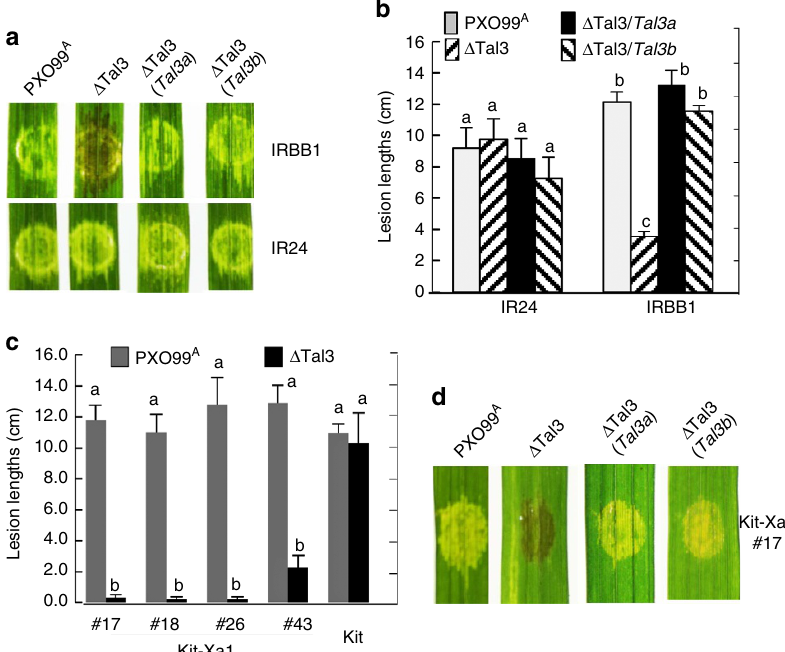
Figure 2 | iTALE genes Tal3a and Tal3b interfere with Xa1 resistance. ( a ) Disease reactions of IRBB1 and IR24. Strains are indicated above the leaves. Brown colouration indicates HR and clearing spots indicate disease reaction. ( b ) Lesion lengths in IR24 and IRBB1 caused by Xoo strains as measured at 12 days post inoculation (DPI). ( c ) Lesion lengths in Xa1 transgenic lines ( n ¼ 4) at 12 DPI. ( d ) Xa1 transgenic line #17 showed HR (brown colouration) to D Tal3 but disease reactions to D Tal3 complementing strains and PXO99 A . Photos were taken at 3 DPI. Error bars (s.d., n ¼ 10, 3 replicates) with the same letter do not differ from each other at P o 0.05 (Tukey’s